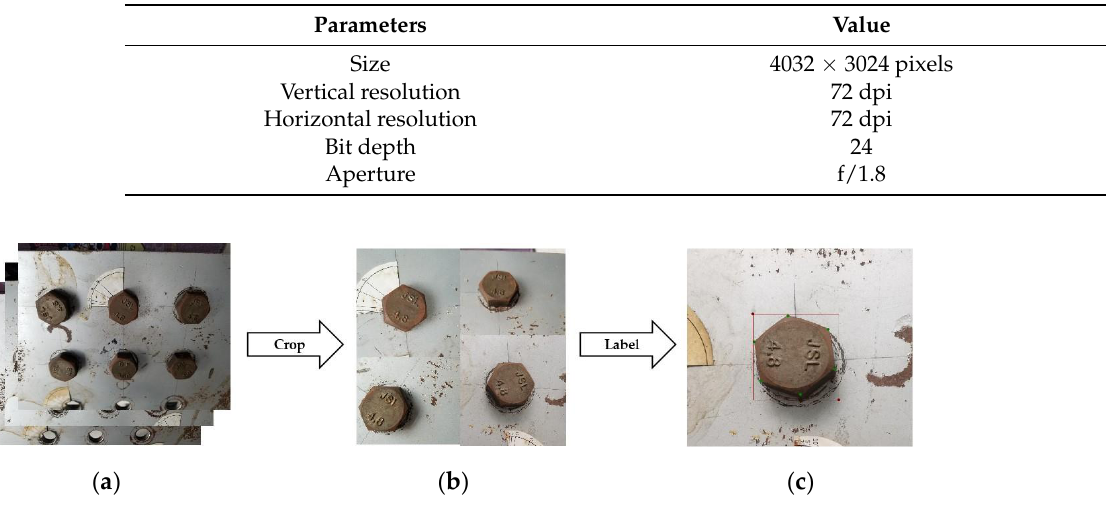
Figure 4. Image processing and labeling. ( a ) Original images; ( b ) Cropped images; ( c ) Labeled image.